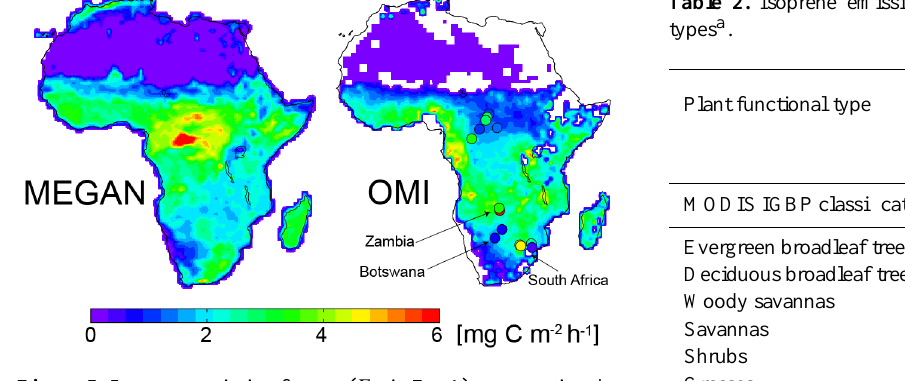
Figure 5. Isoprene emission factors ( E o in Eq. 1) representing the emission flux under standard conditions. Measured landscape-level emission factors from field sites (circles; see Fig. 1 and Table 1b) are compared to those used in MEGAN (left) and obtained with OMI (right). White indicates missing OMI data.